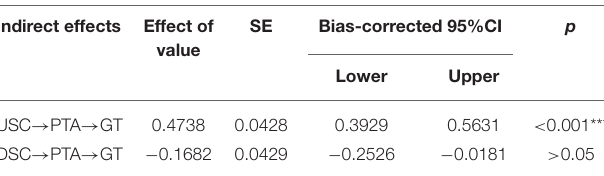
TABLE 6 | Indirect effects